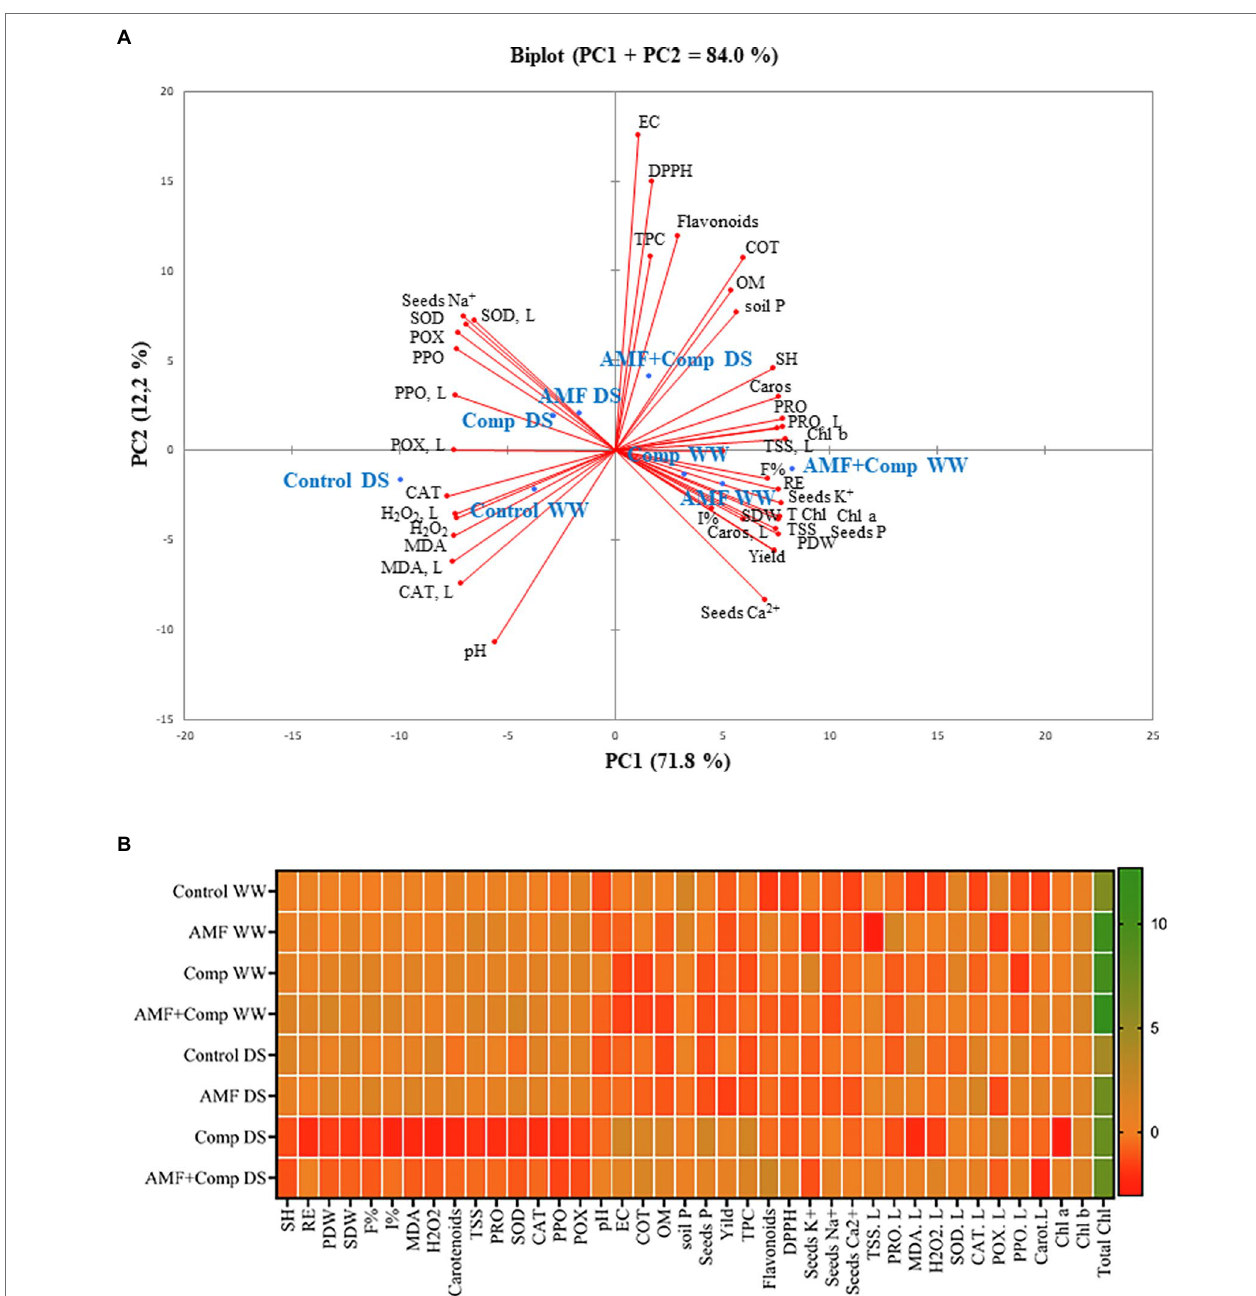
FIGURE 6 | The principal component analysis (PCA) (A) and heat map (B) measured variables and applied treatments. AMF, arbuscular mycorrhizal fungi consortium; AP, soil available phosphorous; Ca 2+ , seed calcium; Caros, seed corotenoid; Caros, L; leaf carotenoid; CAT, seed catalase activity; CAT, L, leaf catalase activity; Chl, leaf chorophyll; Comp, compost; DS, drought stress; EC, electrical conductivity; F%, AMF colonization frequency; I%, AMF colonization intensity; K + , seed potassium; Na + , seed sodium; OM, organic matter; P, seed phosphorus; PDW, plant dry weight; PPO, seed polyphenol oxidase activity; PPO, L, leaf PPO; POX, seed peroxidase activity; POX, L, leaf POX; Prot, seed protein; Prot, L, leaf protein; RE, root elongation; SDW, seed dry weight; SH, shoot height; SOD, seed superoxide dismutase activity; SOD, L, leaf SOD; TFC, seed total flavonoid; TOC, total organic carbon; TPC, seeds total phenol; TSS, seed total soluble sugar; TSS, L, leaf total soluble sugar; and WW,